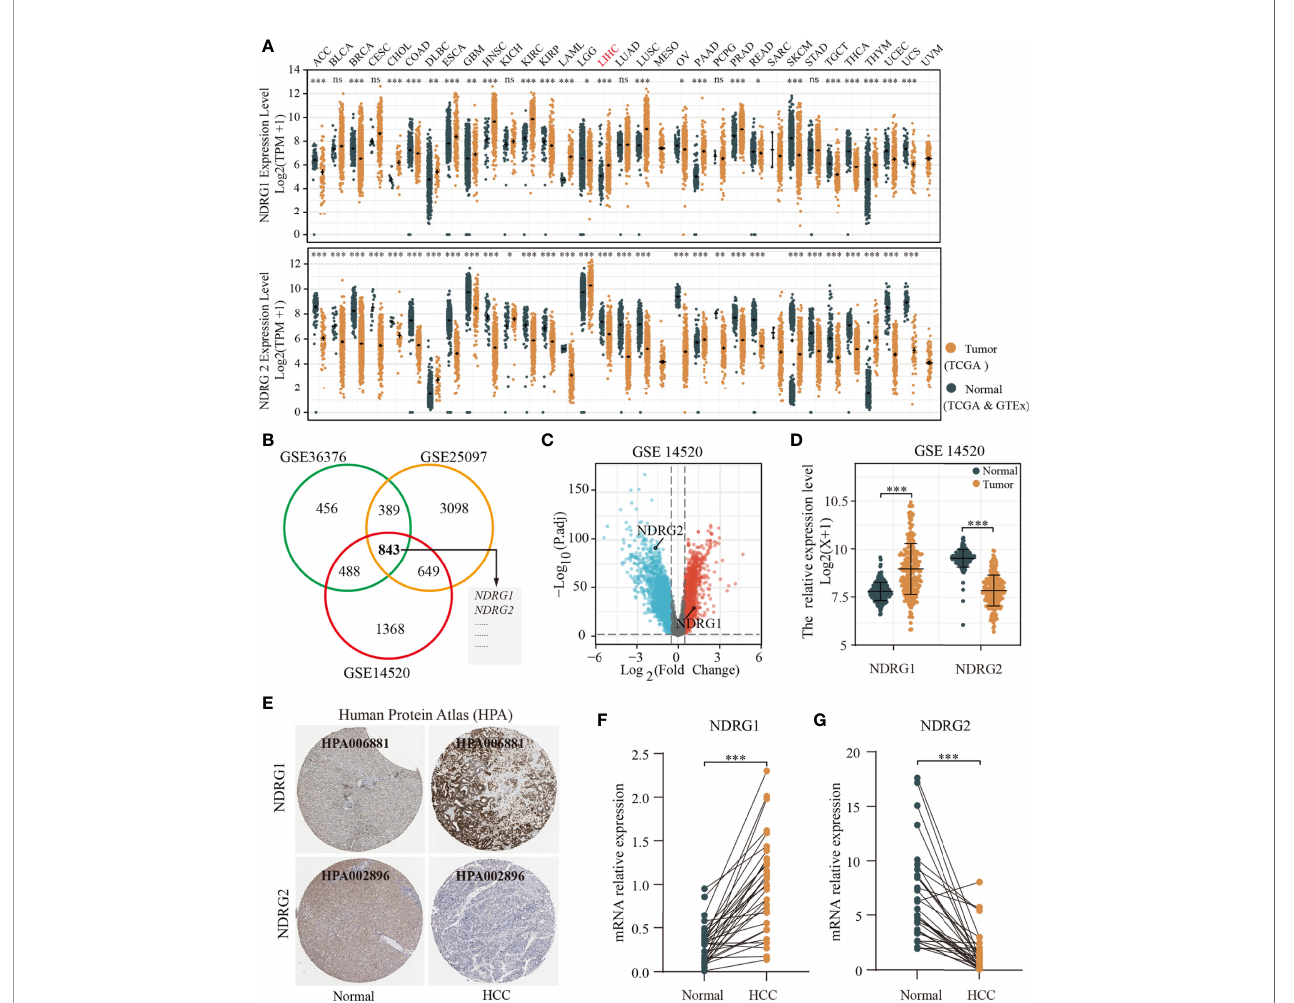
FIGURE 1 | Differential mRNA expression pro fi les of NDRG1 or NDRG2 in different cancer types. (A) The expression levels of NDRG1 and NDRG2 in different cancer types were analyzed based on the TCGA database. (B) Venn plots of DEGs (| log2FoldChange>0.5 and adjusted P < 0.05) identi fi ed in three GEO databases. (C) The volcano plots for all the coding genes obtained in the GSE14520 database. Red and blue dots represent up-regulated DEGs and down-regulated DEGs, respectively. (D) The scatter diagram of NDRG1 and NDRG2 mRNA expression levels in GSE14520 database. (E) The protein expression of NDRG1 and NDRG2 in LIHC was obtained from the Human Protein Atlas (HPA, https://www.proteinatlas.org/). (F, G) The expression levels of NDRG1 and NDRG2 were obtained by qPCR assay in liver carcinoma and para-carcinoma tissues. * P < 0.05; ** P < 0.01; *** P < 0.001. ns, no signi fi